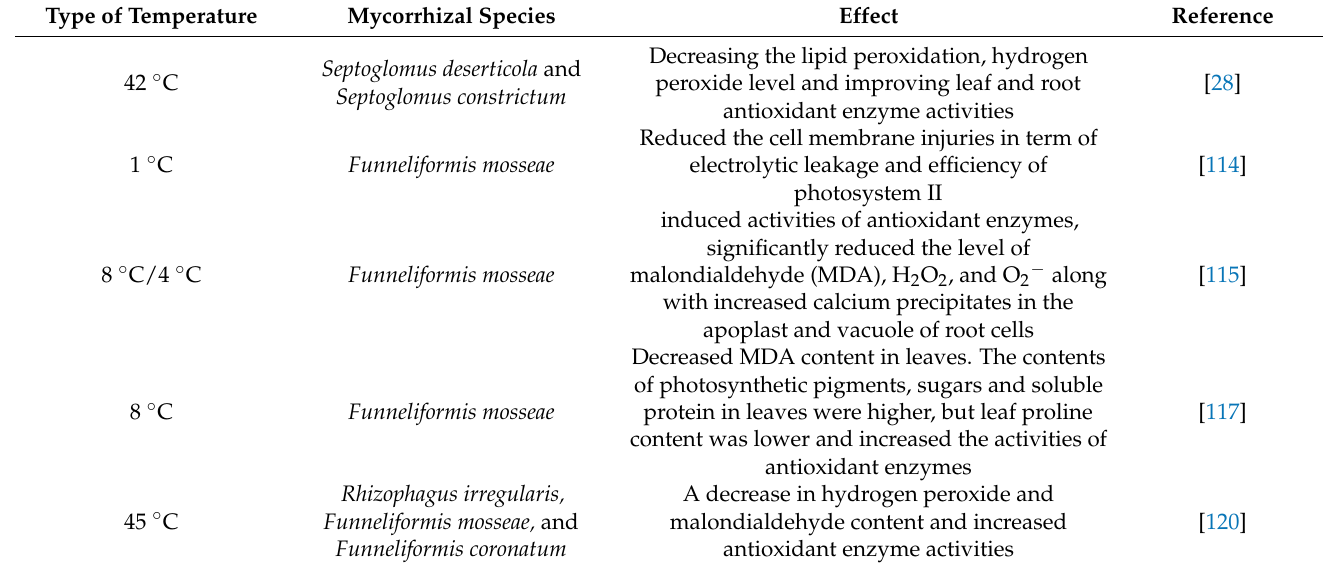
Table 3. Application of arbuscular mycorrhizal fungi on temperature stress